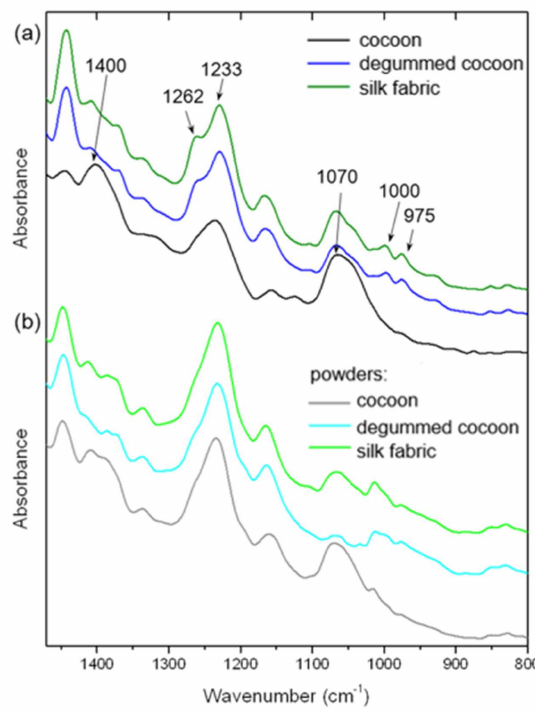
Figure 6. Infrared absorption spectra of ( a ) raw, and degummed silk cocoons, silk fabric and ( b ) silk powders from raw cocoons, degummed cocoons, and silk fabric. The maxima of the main peaks from the infrared fingerprint region for amide II and amide III did not shift for all powders regardless of the silk source. The maxima of the amide I band slightly shifted to the higher values of 1632, 1626, and 1629 cm − 1